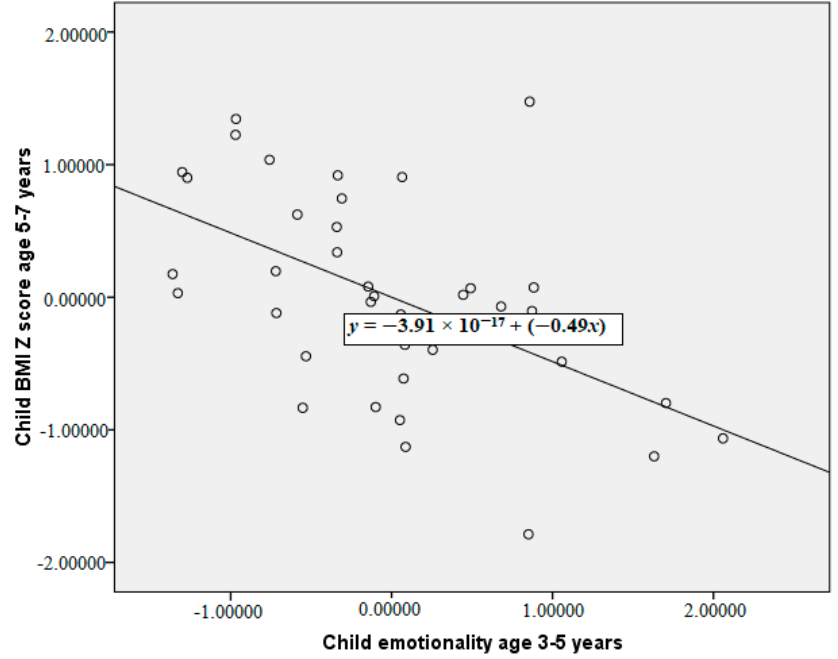
Figure 3. Partial correlation between child emotionality at 3–5 years and child BMI Z-score at 5–7 years, controlling for child BMI Z-score at 3–5 years (plot of the unstandardised residuals).